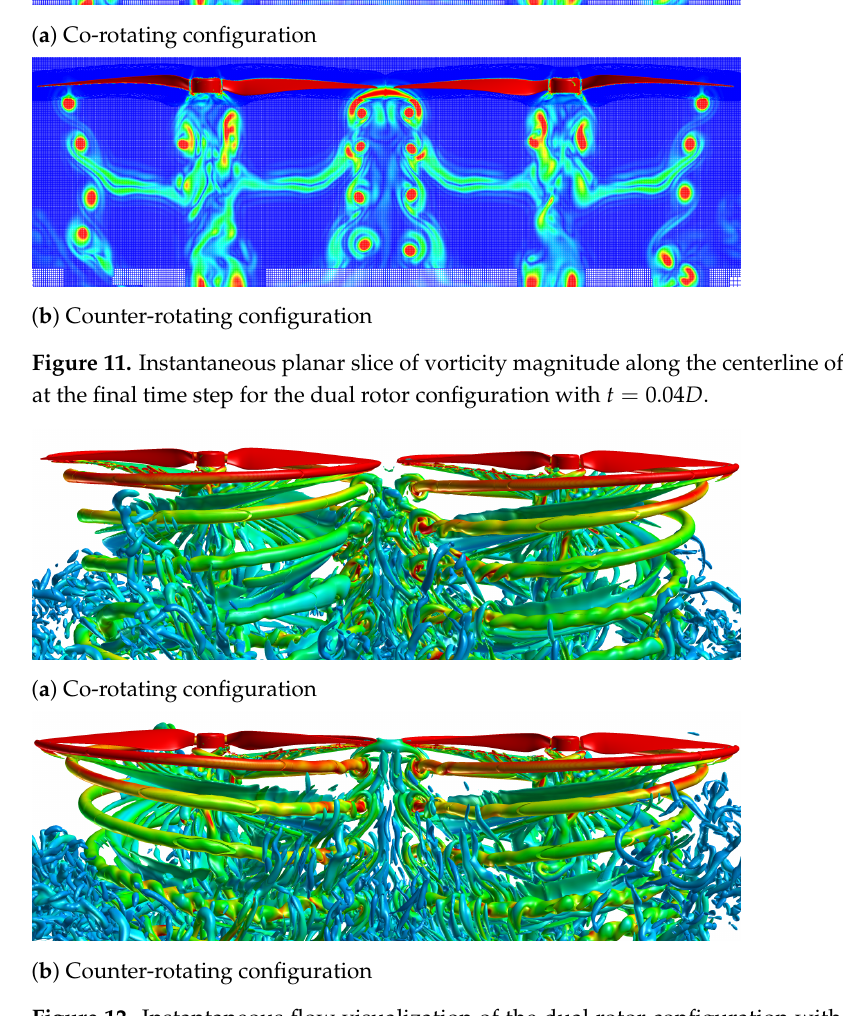
Figure 12. Instantaneous flow visualization of the dual rotor configuration with t = 0.04 D at the final time step. The blade surfaces and iso-surfaces of q-criterion = 0.001 are colored by the vorticity